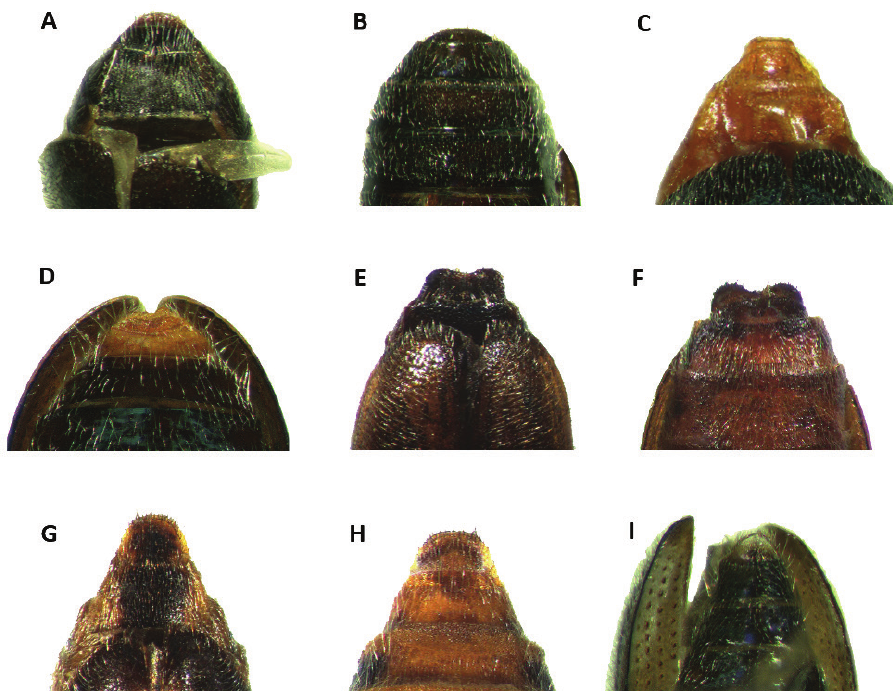
Figure 17. Pygidium of: A Neocallotillus elegans ( vafer ) dorsal (female) B Neocallotillus elegans ( vafer ) ventral (female) C Cymatoderella patagoniae dorsal (male) D Cymatoderella patagoniae ventral (male) E Monophylla terminata dorsal (male) F Monophylla terminata ventral (male) G Monophylla terminate dorsal (female) H Monophylla terminate ventral (female) I Onychotillus vittatus ventral (male).